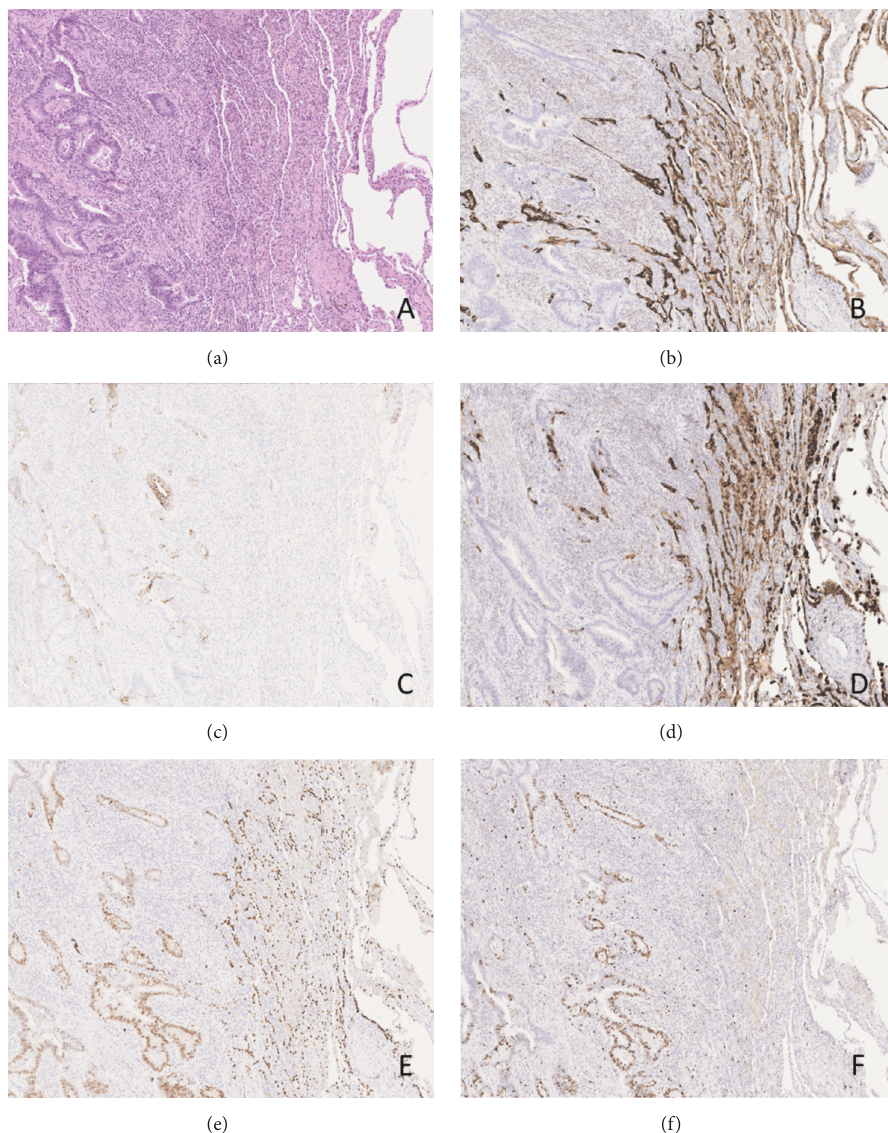
Figure 1: (a) Representative image of the neoplasm (on the left) with normal healthy tissue (on the right) ( × 200); (b) CK7 immunohisto- chemical expression ( × 200); (c) CK20 immunohistochemical expression ( × 200); (d) Napsin A immunohistochemical expression ( × 200); (e) TTF-1 immunohistochemical expression ( × 200); (f) Ki67 immunohistochemical expression ( ×